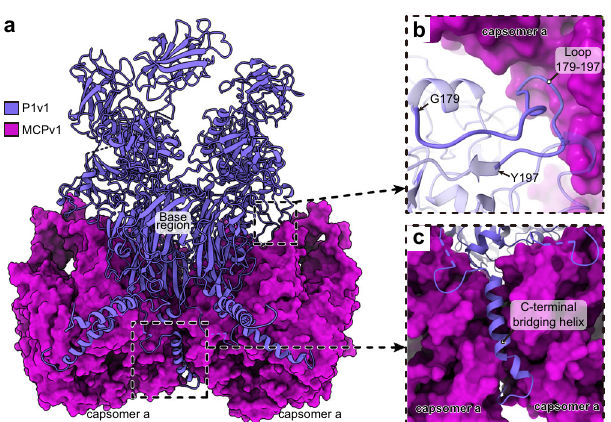
Fig. 3 | Structures of the pseudo-hexameric and pentameric capsomers. a Ribbon diagrams of all six types of pseudo-hexameric capsomers. b Ribbon diagramsofthetwotypesofpentamericcapsomers.TheC-terminalbridginghelix,